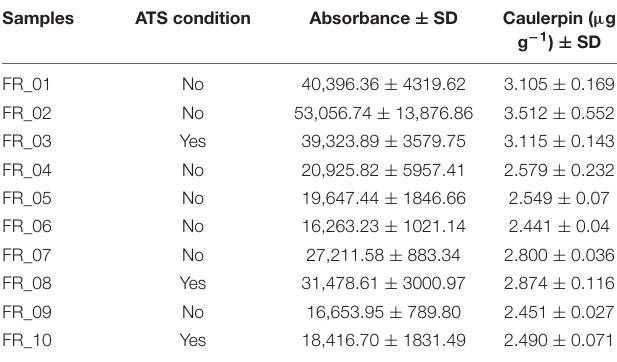
TABLE 3 | Caulerpin bioaccumulation in D. sargus livers expressed as µ g g − 1 dry weight and indication of the ATS condition. Standard deviation was calculated on n = 3.